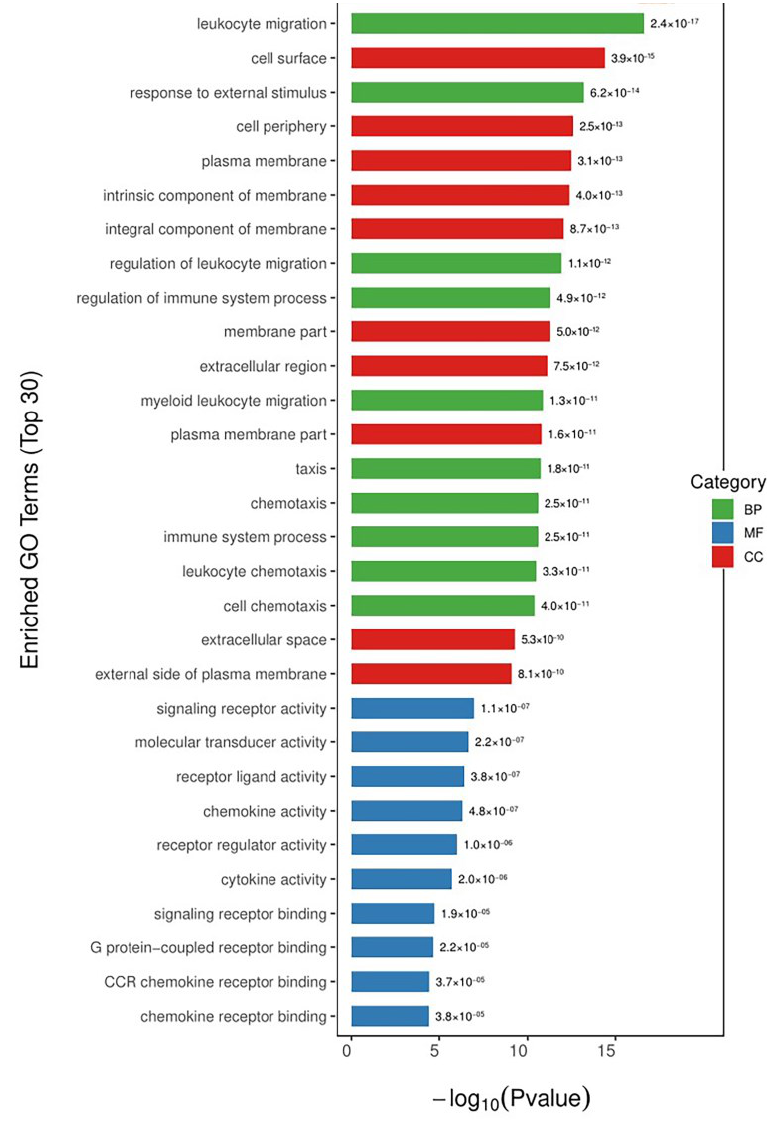
Figure 4. GO enrichment of DGEs. The chart was constructed by plotting the p -value on the x -axis and entries are listed in ascending order of p -values. Green indicates biological processes. Blue indicates molecular functions. Red indicates cellular components.